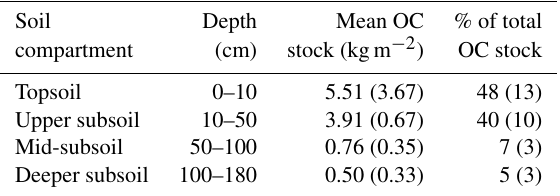
Table 2. Mean OC stocks in bulk soil of different soil compartments down to 180cm presented as absolute values and as a percent of total soil OC stock ( n = 12; standard deviation is given in brackets). Soil Depth Mean OC % of total compartment (cm) stock (kgm − 2 ) OC stock Topsoil 0–10 5.51 (3.67) 48 (13)